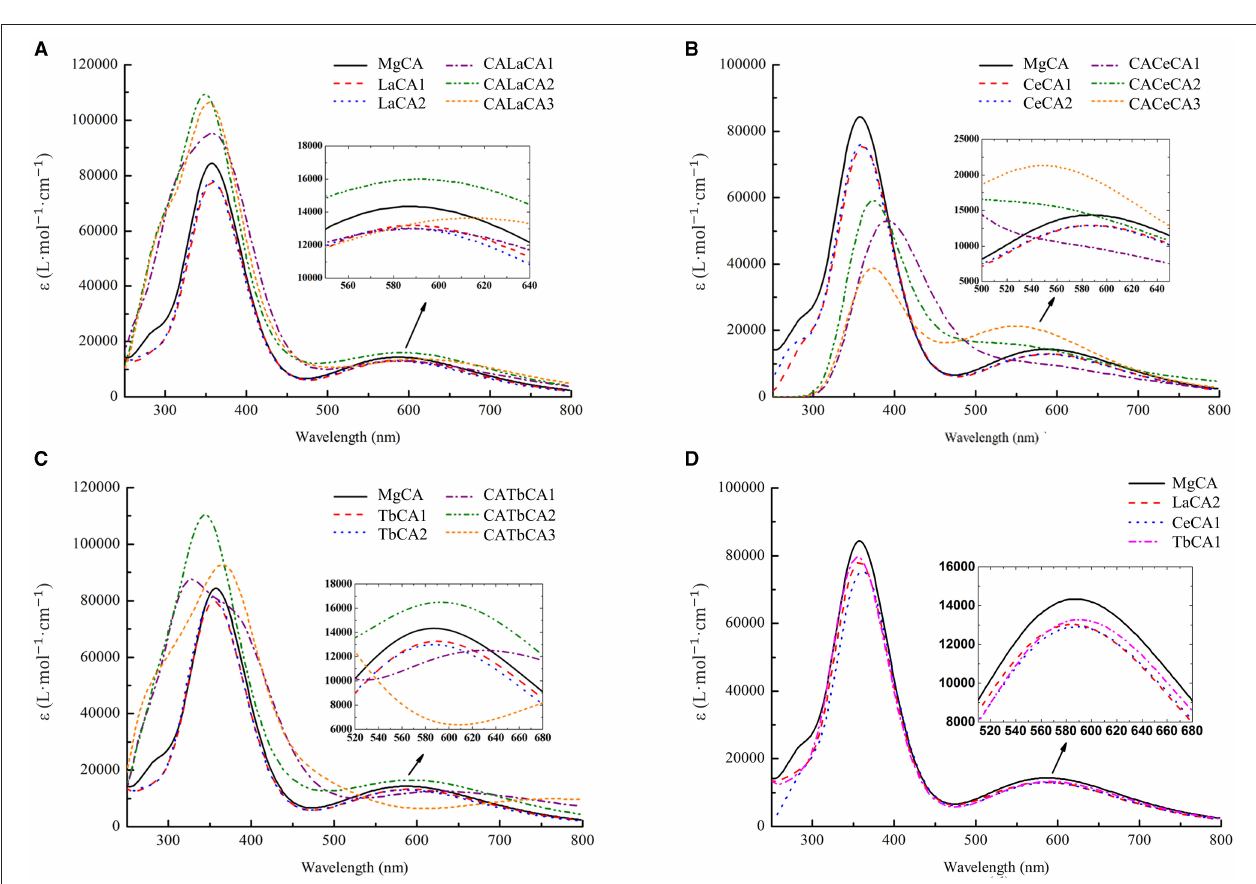
FIGURE 6 | Simulated electronic absorption spectra of different compounds (La, Ce, and Tb) in ethanol. (A) Mg-chlorophyll a and La-chlorophyll a, (B) Mg-chlorophyll a and Ce-chlorophyll a, (C) Mg-chlorophyll a and Tb-chlorophyll a, (D) Mg-chlorophyll a and lanthanides mono-chlorophyll a (LaCA2, CeCA1 and TbCA1).